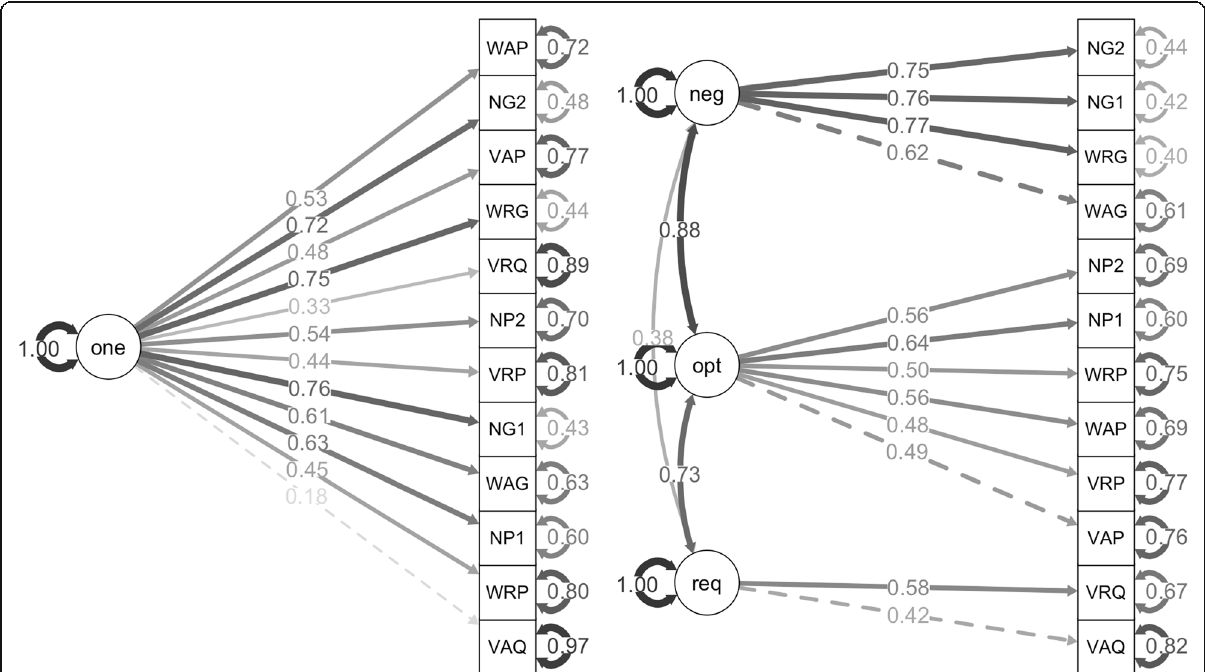
Fig. 6 One-factor model (left) and level of spatial-thinking model (right) for ratings of visualization helpfulness. One-factor model (one); negligible (neg), optional (opt), and required spatial thinking (req). The math problem were labeled first by type: visual (V), word (W), and notation (N); second by context: real-world (R), abstract (A), and notation (N); and third by level of spatial thinking: required (Q), optional (P), and negligible (G). Since notation types were also notation contexts, we balanced the number of problems by including two of each of these problems (indicated with a 1 and